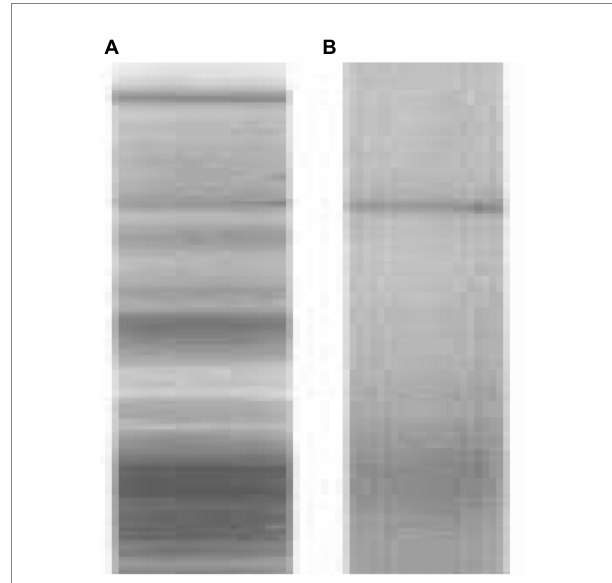
FIGURE 2 Non laser irradiated protein of Cladosporium cladosporioides Lane (A) Laser irradiated protein of C. cladosporioides showing microbial inhibition by disappearance of all major protein bands Lane (B) (Geweely,